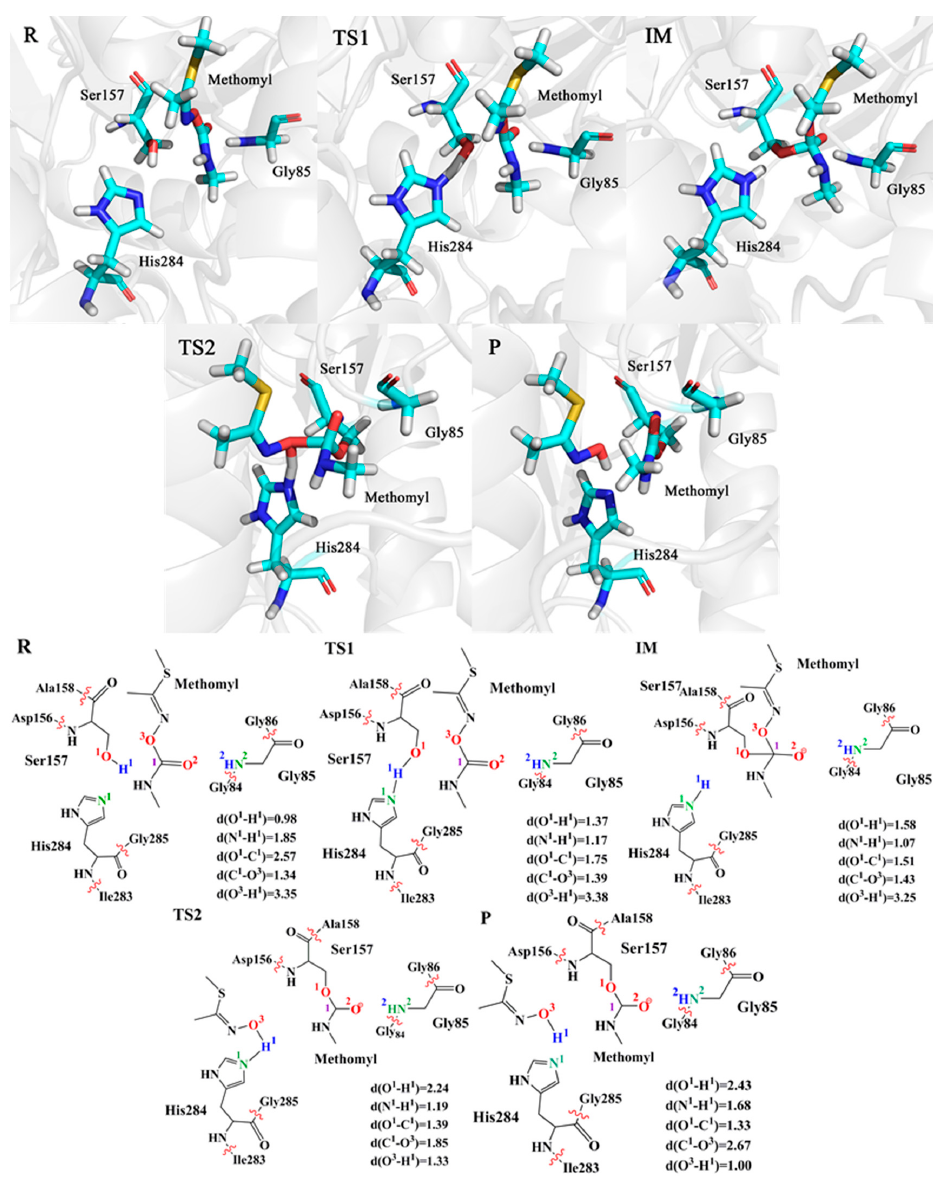
Figure 3. Optimized structures and key bond distances for the R, TS1, IM, TS2 and P. The unit of distance is Å.